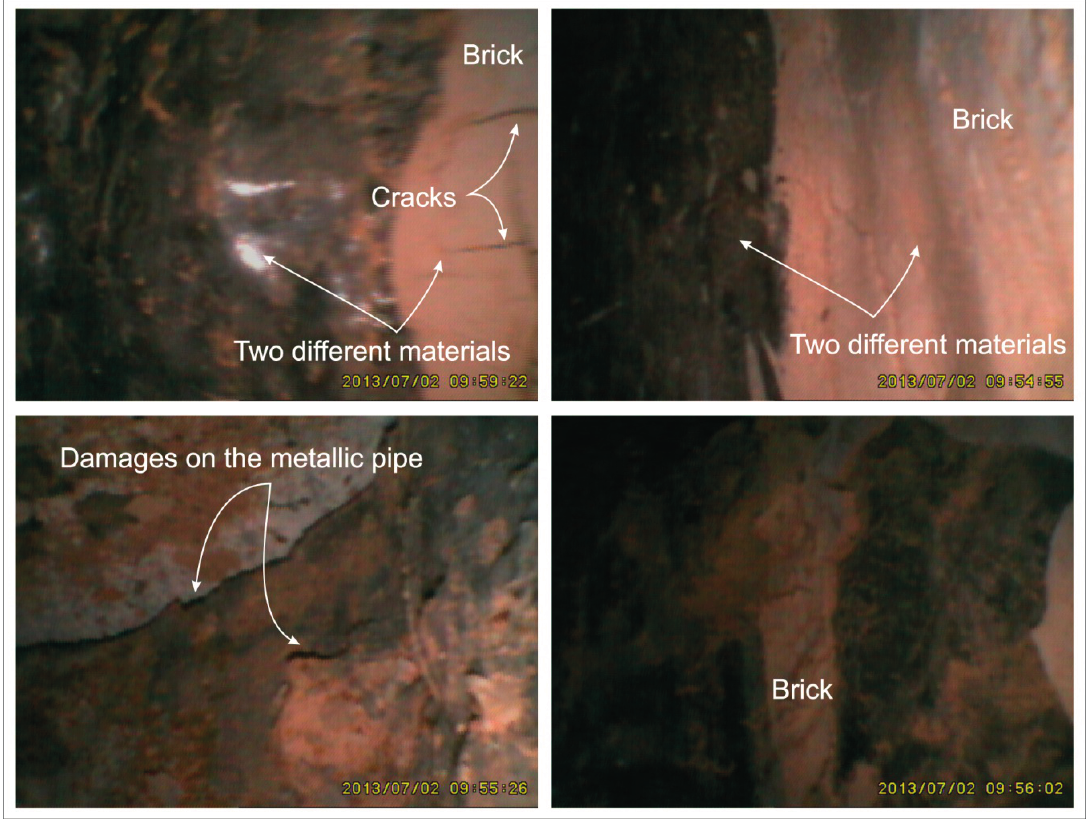
Figure 10. Some endoscopy images, highlighting different parts and damages inside the